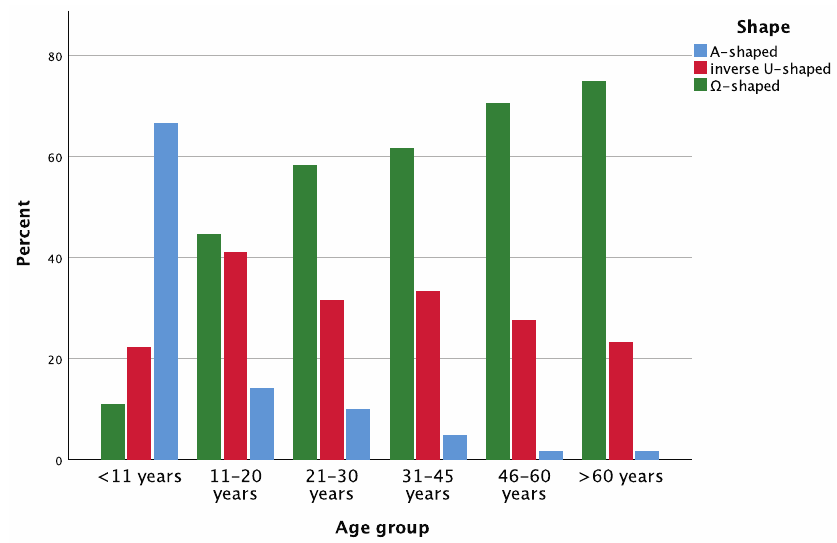
Figure 3. Distribution of the three shapes with a significant difference between the different age groups ( p < 0.0001).